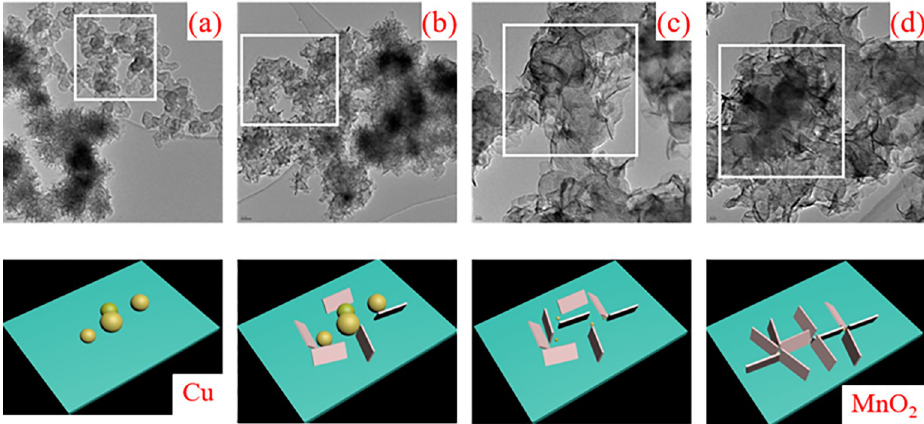
Fig 5. Growth process of nano flower MnO 2 : (a) original Cu particles; (b) a small part of copper particles take part in reactions and slices form; (c) most of the copper particles convert to slice MnO 2 ; and (d) copper particles are consumed completely and slices assemble themselves, and flower-like shape is